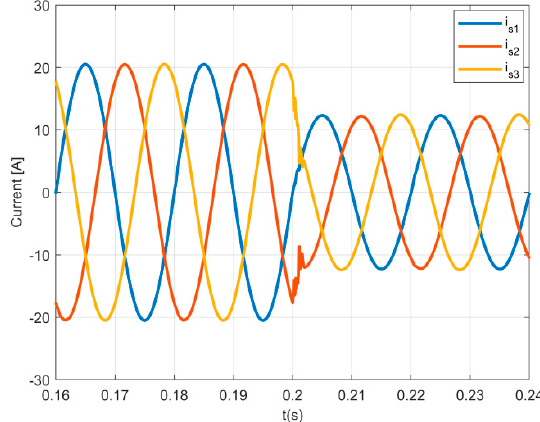
Figure 9. The three-phase charger input currents in transient conditions.